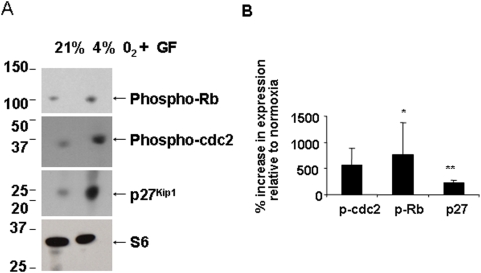
Changes in OL cell cycle proteins in 4% O2.Whole cell lysates from OLs cultured at 21% O2 or 4% O2 in the presence of GFs, were analyzed by immunoblot analysis for phosphorylation state of cell cycle proteins Rb and cdc2, and for the negative regulator of cell cycle, p27Kip1. Ribosomal S6 protein was used as a loading control. The approximate sizes for Rb, cdc-2, p27Kip1 and ribosomal S6 protein are 110 kDa, 34 kDa, 27 kDa and 32 kDa, respectively. Representative Western blot from 3 different preparations shows an increase in phosphorylated forms of Rb and cdc-2, and total p27Kip1 levels in hypoxia. (B) Densitometric analysis was done by normalizing protein levels to ribosomal S6 protein levels. The percent increase in the expression of cell cycle proteins is shown relative to levels in 21% O2 (* p<0.05, ** p<0.01). Data shown are representative of three separate studies.